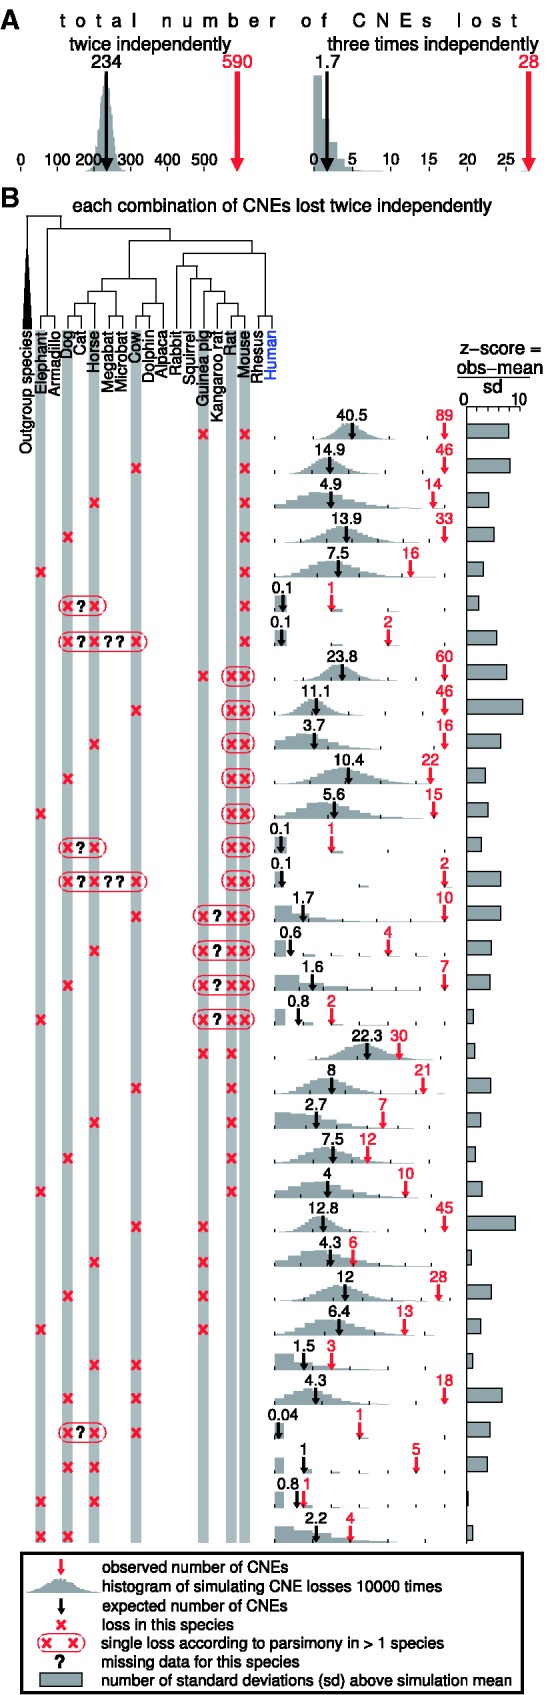
CNE loss frequencies are not uniform. (A) The observed number of CNEs lost twice and three times (red arrow) is significantly more than expected from two methods using a uniform loss model (black arrow is the calculated point estimate, histogram of simulations in grey). The observed number of 590 CNEs lost twice corresponds to a z-score (number of standard deviations above the simulation average) of 24 and the observed number of 28 CNEs lost 3-times corresponds to a z-score of 20. The maximum number of CNEs lost twice and 3-times in the simulation is 285 and 9, which gives an empirical P-value <0.0001 for the observed independent CNE losses. (B) All observed combinations of two independent CNE losses. The rightmost chart boundary is either the maximum of the 10 000 simulation iterations or the observed number of losses. Outgroup species are opossum, platypus, chicken, lizard or zebra finch. Human was used as the reference species.